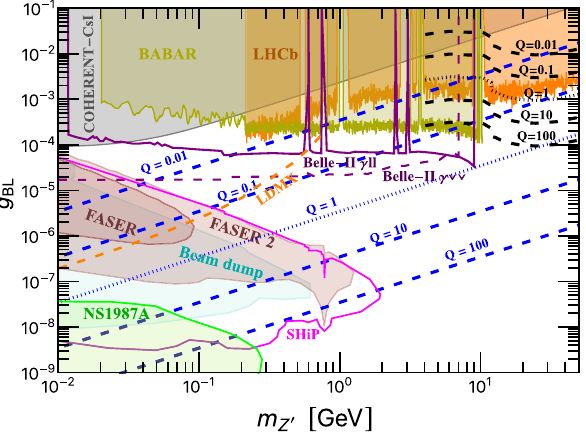
Fig. 2 Exclusion regions in the ( M Z (cid:2) , g BL ) plane for the freeze- out DM scenario. The diagonal blue lines from top to bottom corre- spond to Q = 0 . 01 , 0 . 1 , 1 , 10, 100, respectively. Along these lines, 100% of the observed DM is reproduced. For m Z (cid:2) > 4 GeV, the curved black lines from top to bottom corresponding to Q = 0 . 01 , 0 . 1 , 1 , 10, and 100, respectively are the bounds from various DM direct detection experiments such as Dark-Side-50 [31], PandaX-II [32], LUX [33], and XENON1T [34]. The regions excluded by BABAR [28], LHCb dark photon searches [29,41,42], by various beam dump experiments, and COHERENT-CsI data [43] are depicted by the light-green, light- orange, cyan, and gray shaded region, respectively (see text for details). The light-green region [44–46] is excluded from supernova SN 1987 observation [48 ? ,49]. The search reach of the various “Lifetime Fron- tier” experiments FASER [35], planned FASER 2, Belle II [50], LDMX [38], and SHiP [37] experiments are depicted by the dark-pink region, light-pink region, purple lines, and orange dashed line, respectively